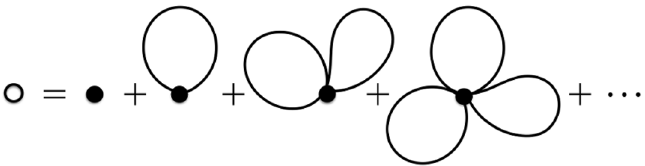
Figure 2 . The eigenoperator is equal to its physical limit (cid:27) (cid:14) ( n ) ( ’ ), plus all possible tadpole cor- rections. Those corrections generated by attaching to (cid:27) , terminate eventually (since the monomial will run out of (cid:12)elds), while ’ -tadpole corrections to (cid:14) ( n ) ( ’ ) go on forever but resum to (cid:14) ( n ) do not draw the external legs, an in(cid:12)nite number of which attach to (cid:14) ( n )